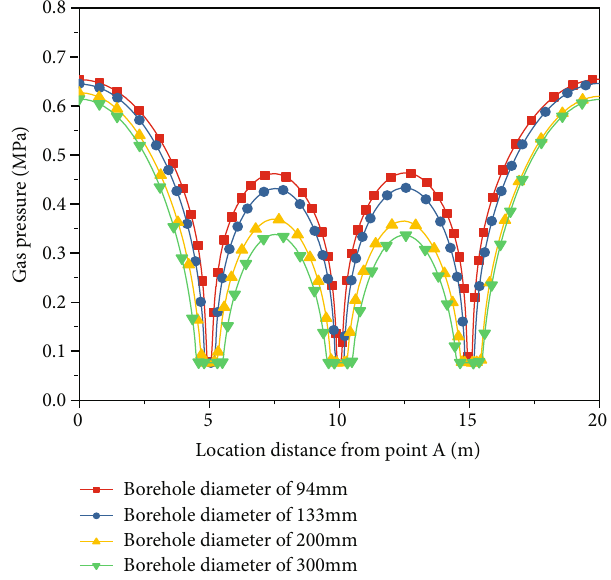
Figure 10: Gas pressure curve on A-B line in soft coal seam after 120 days ’ extraction with di ff erent borehole The contour of gas pressure distribution in soft coal seam after 120 days of extraction under di ff erent borehole diame- ters (94 mm, 133 mm, 200 mm, and 300 mm) is shown in Figure 11. The gas content of 8 m 3 /t is taken as the standard of e ff ective extraction. With the increase of borehole diame- ter, the e ff ective extraction range increases. When the diam- eter of boreholes is 94 mm, 133 mm, and 200 mm, there is a nonstandard extraction area between the two boreholes, and the area decreases with the increase of boreholes. When the borehole diameter increases to 300 mm, the substandard area between the two boreholes gradually disappears. It indi-